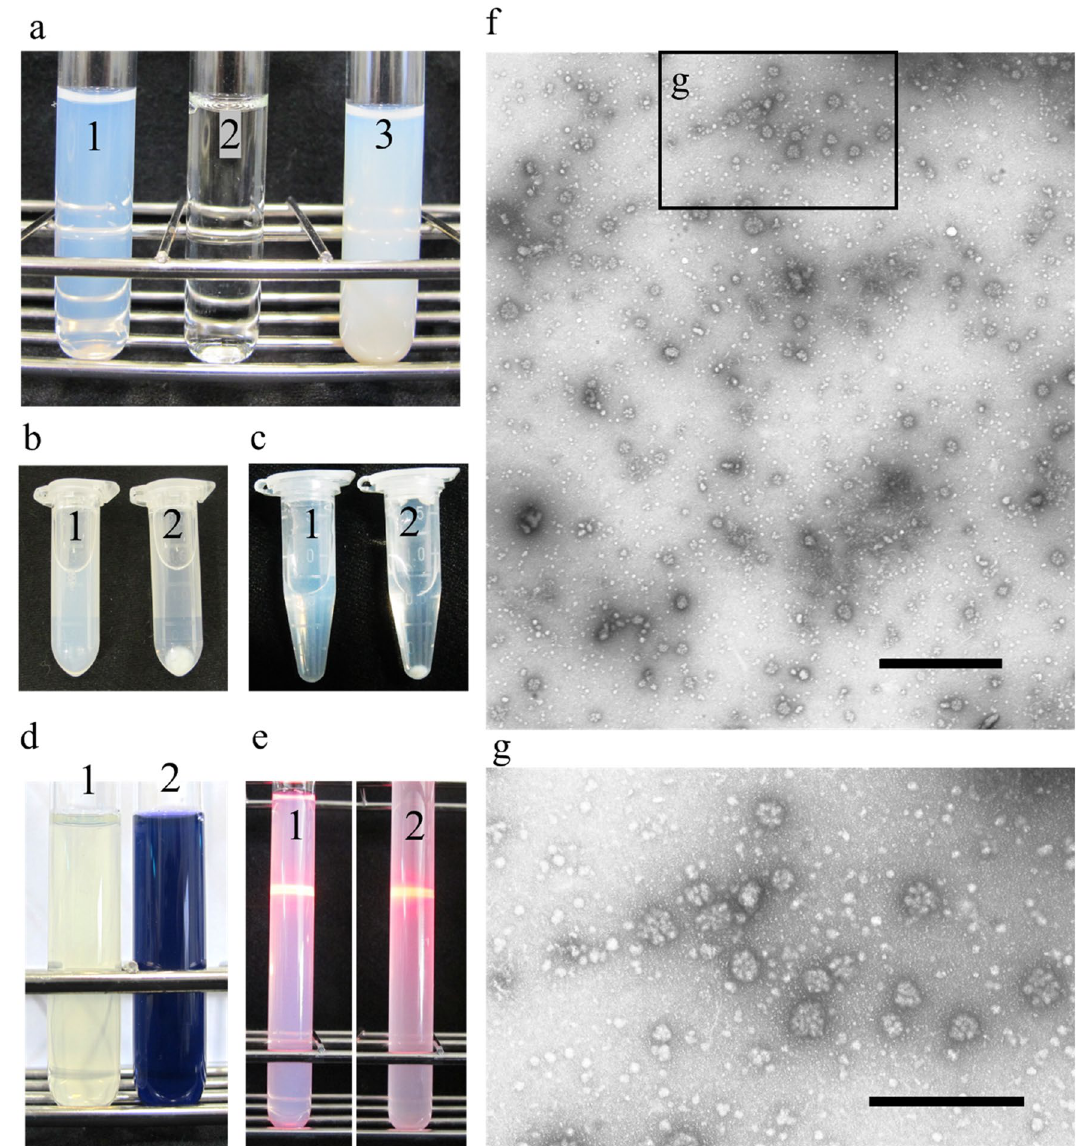
Figure 2. Analysis of components that whiten boiled clam soup. ( a ) Boiled soup of basket clam (1); ultrafiltered flow fraction (2); ultrafiltered supernatant (3); ( b ) TCA was added to a final concentration of 10% to boiled basket clam soup (1) and centrifuged (2). ( c ) Ammonium sulphate was added to a final concentration of 60% to boiled basket clam soup (1) and centrifuged (2). ( d ) Ninhydrin was added to a final concentration of 1% to boiled basket clam soup (1) and heated (2). ( e ) Milk was diluted 1:10 with distilled water and irradiated with a laser beam (1); irradiated boiled basket clam soup (2). ( f ) Negative stain image of boiled soup in transmission electron microscopy. Bar: 1 µm. ( g ) Enlarged image of particles. Bar: 0.5